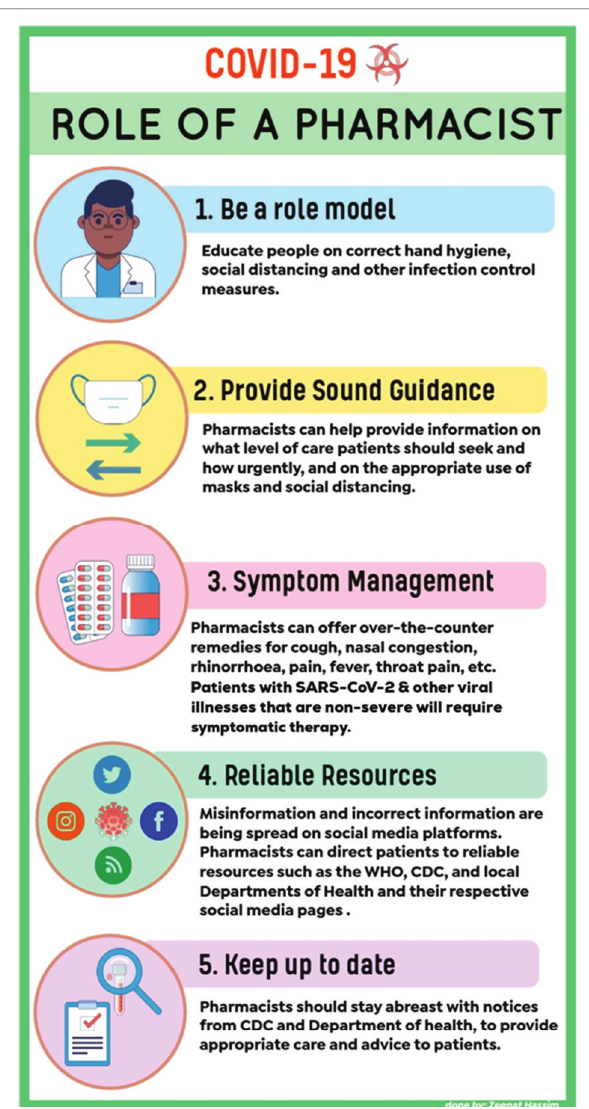
FIGURE 3: A basic summary of the role of the pharmacist in the management of COVID-19. 1,12,13